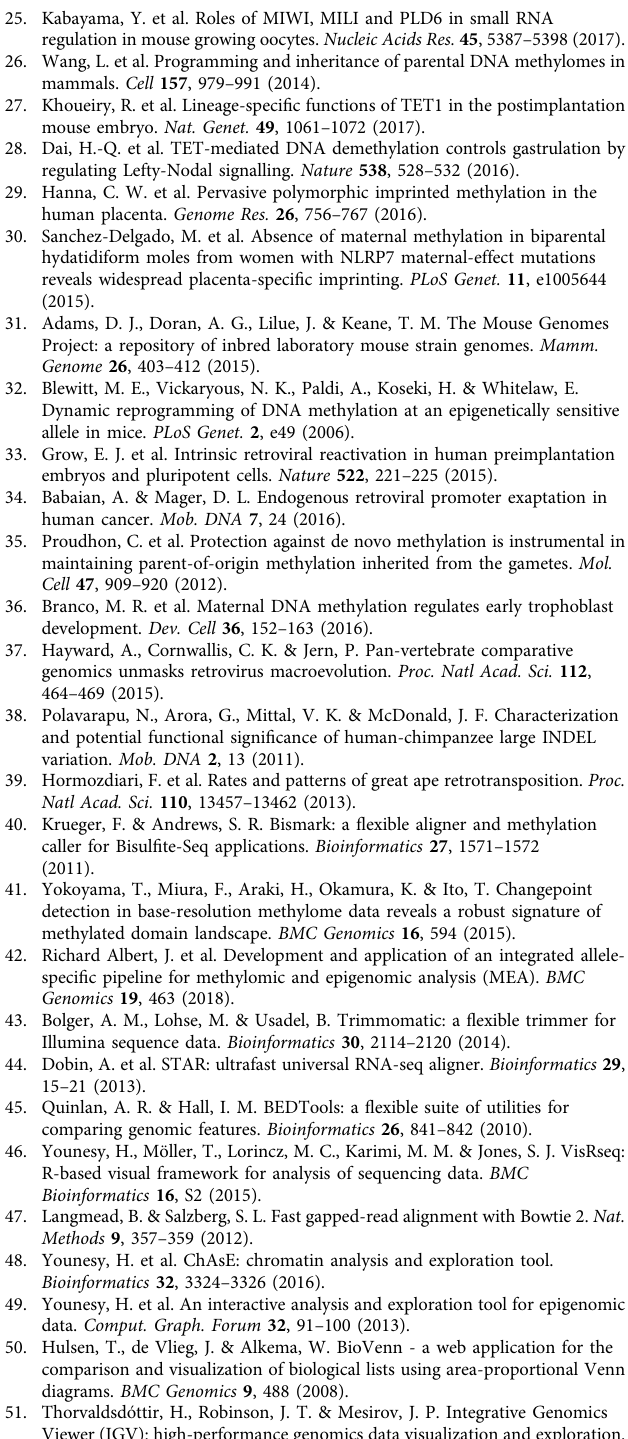
Data availability . Details of the datasets generated are presented in Supplementary Table 3. ChIP-seq and RNA-seq datasets have been deposited at the Gene Expression Omnibus database (accession GSE112622) and WGBS datasets have been deposited at the DNA Databank of Japan (accession nos. DRA006642, DRA006679, and